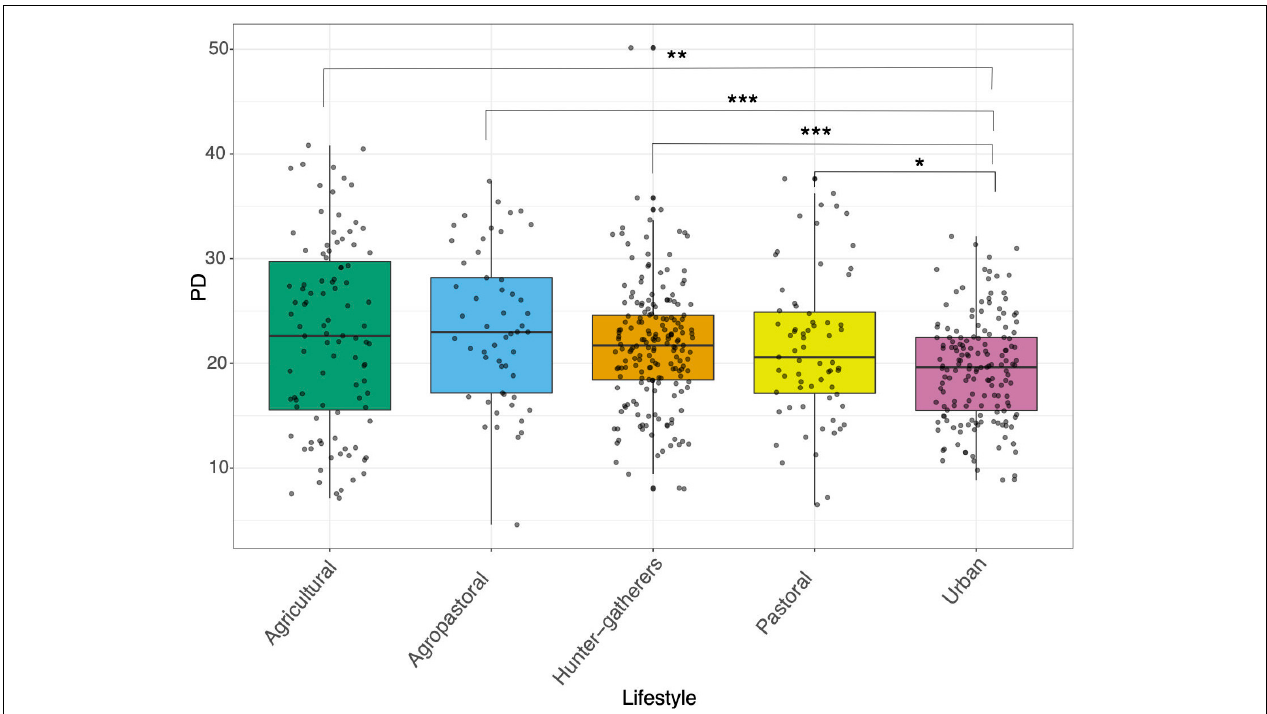
FIGURE 1 | Alpha diversity of human gut microbiome across lifestyles. Boxplot of Phylogenetic diversity analysis (PD) between hunter-gatherers, agricultural, agropastoral, pastoral, and urban populations. Asterisks denote statistical significant differences given by Wilcoxon rank-sum test (* p < 0.05, ** p < 0.01, *** p < 0.001, **** p < 0.0001).